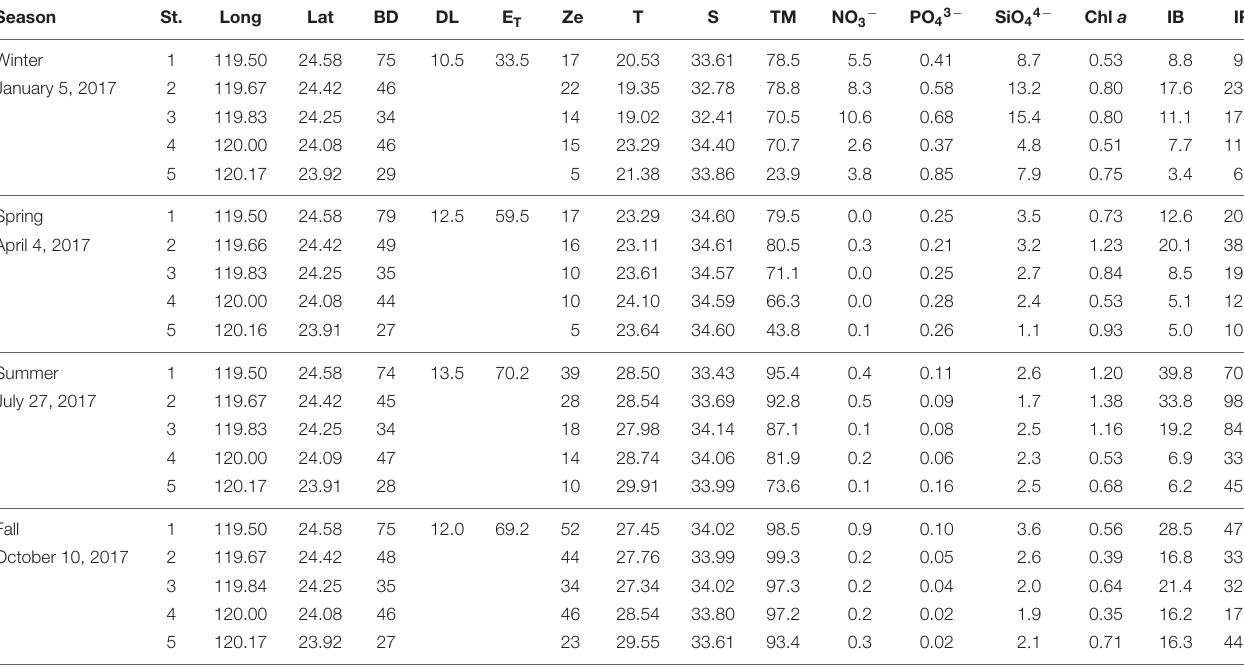
TABLE 1 | Seasonal variation of day length, total photosynthetic active radiation (PAR) above the sea surface, euphotic zone depth (Ze), euphotic zone averaged marine environmental data, and primary production for each station. Season St.